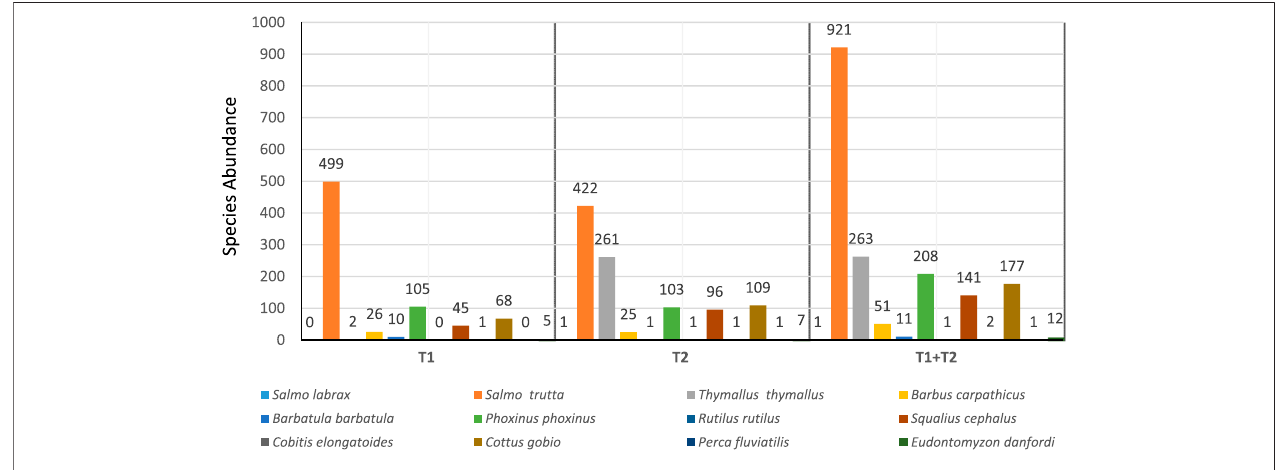
FIGURE 2 | Fish species abundance in the two river sections T1 and